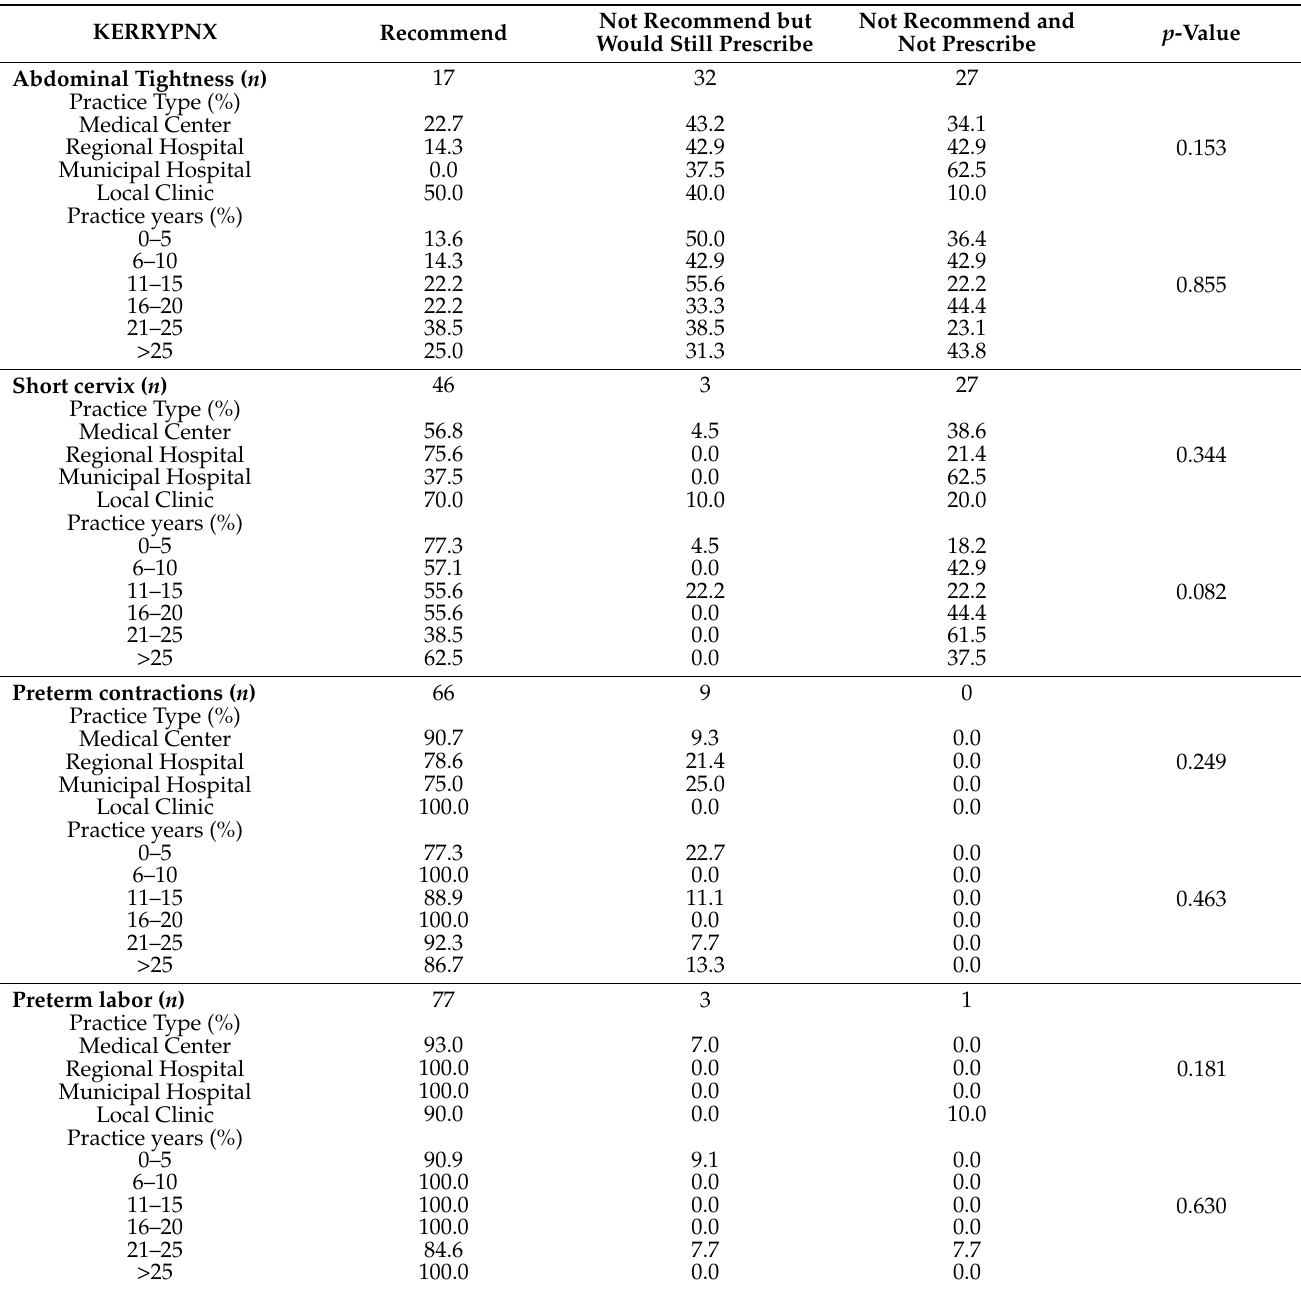
Table 4. Differences between respondents who would recommend, would not recommend but would still prescribe if the patient desires, and would not recommend tocolysis ( n =